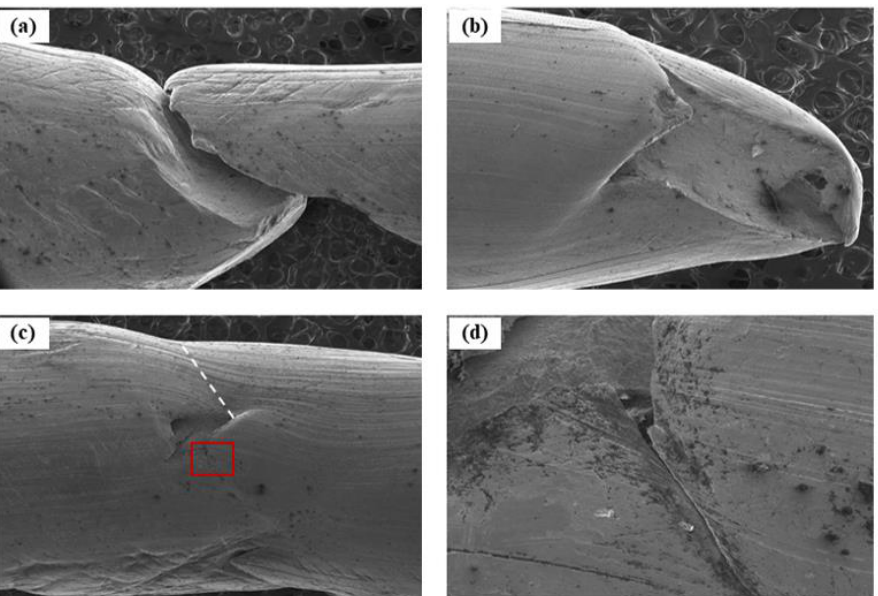
Figure 11. SEM micrographs of DTE fragment surface near the fracture region in the FGH Cu: ( a ) Fracture region between Frag. 1 and Frag. 2. ( b – d ) Fragment surface of Frag. 2 indicates resistance in the onset of strain localization marked by the white dash line.